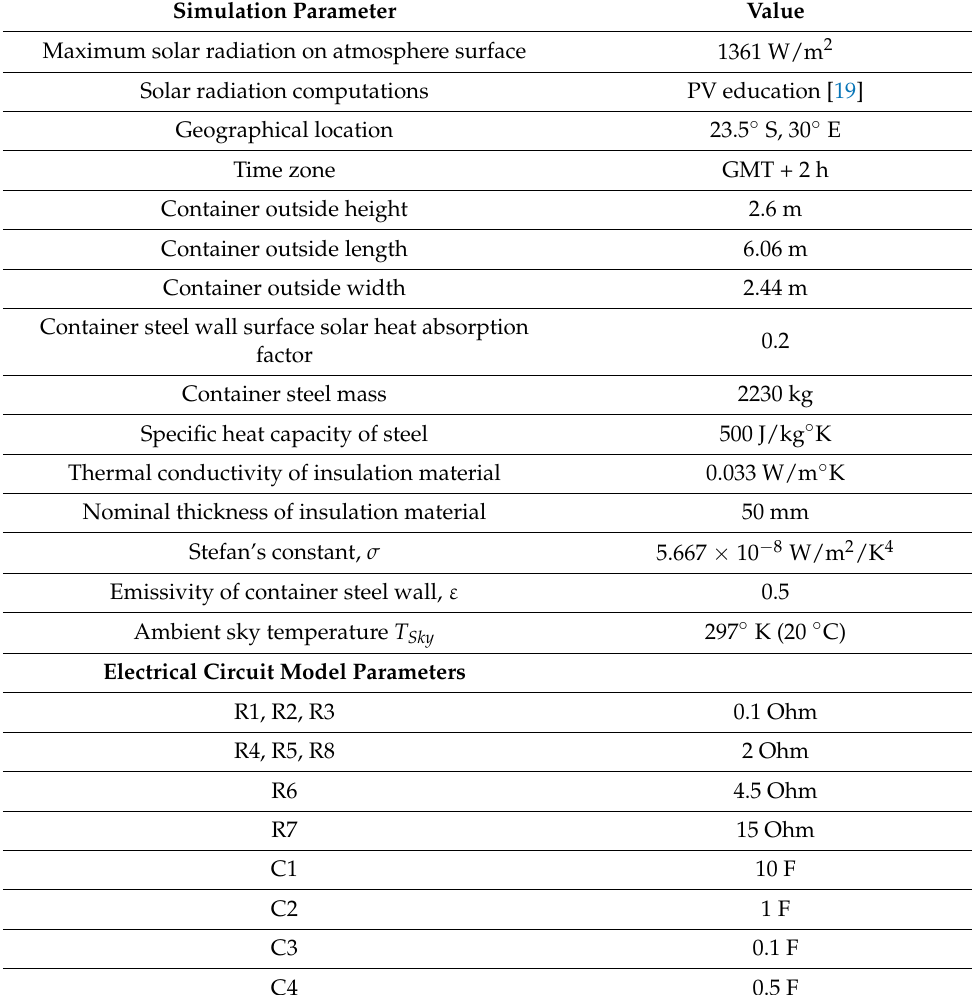
Table 2. Model parameter